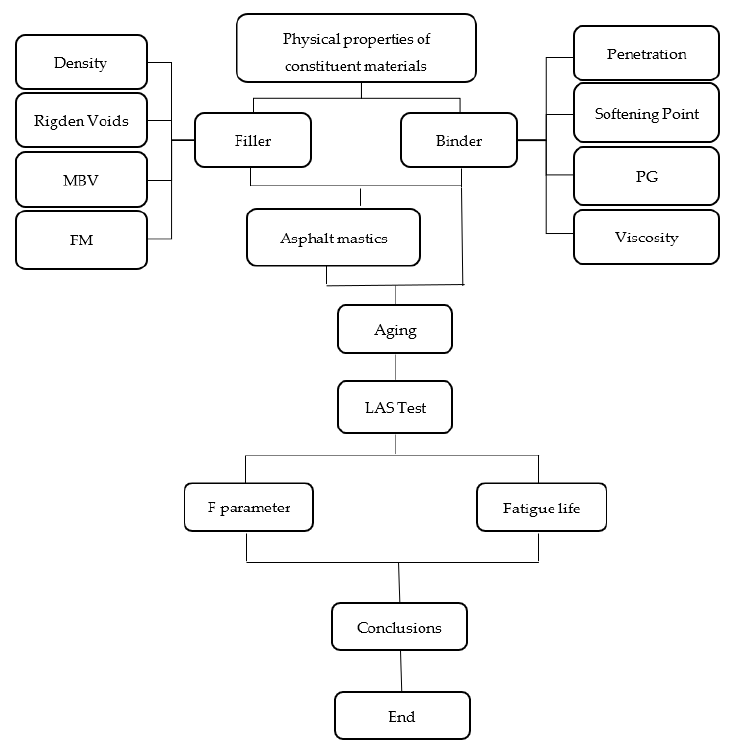
Figure 1. Flow chart for the research outline of the study.